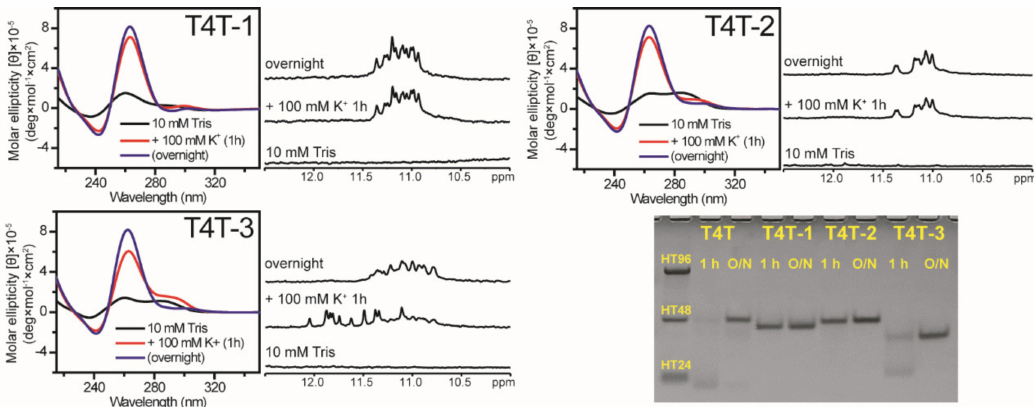
Figure 3. The e ff ect of middle loop base on G4 formation of (G 3 TG 3 N 4 G 3 TG 3 ) sequences. CD and NMR spectra of T4T-1, T4T-2, and T4T-3 in 10 mM Tris and after 1 h and overnight (O / N) addition of 100 mM K + together with their PAGE assays of marker bands of HT24 (T 2 AG 3 ) 4 , HT48 (T 2 AG 3 ) 8 , and HT96 (T 2 AG 3 ) 16 (lane 1) and each sequence after 1 h and O / N addition of 100 mM K + for T4T, T4T-1, T4T-2, and T4T-3. The same DNA concentration of 100 µ M was used in the experiments of CD, NMR and PAGE of this